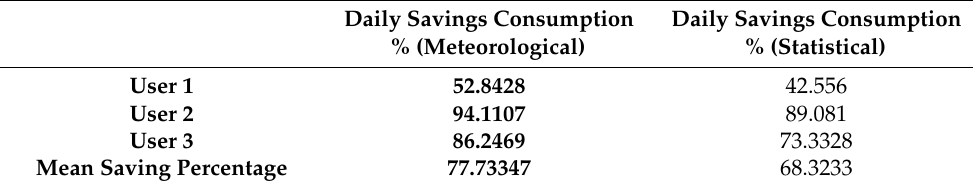
Table 2. Saving percentage.